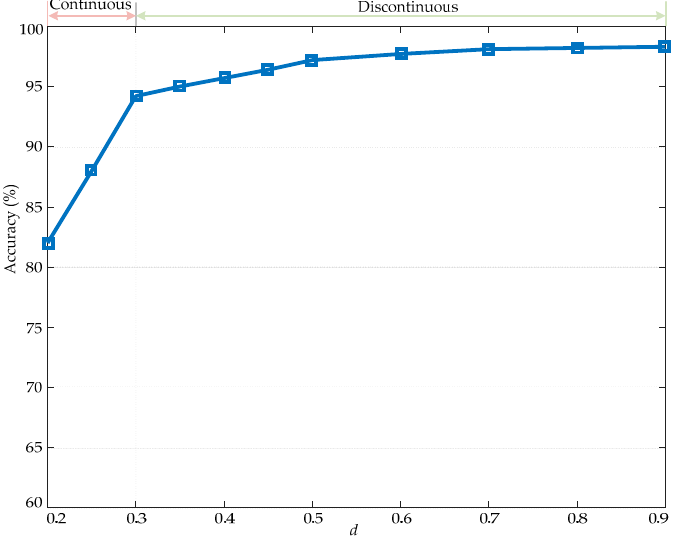
Figure 7. Identification accuracies of coupling coefficient when d varies from 0.2 to 0.9. Table 2. Coupling coefficient identification with d is 0.5, 0.6 and R b is 10 Ω .